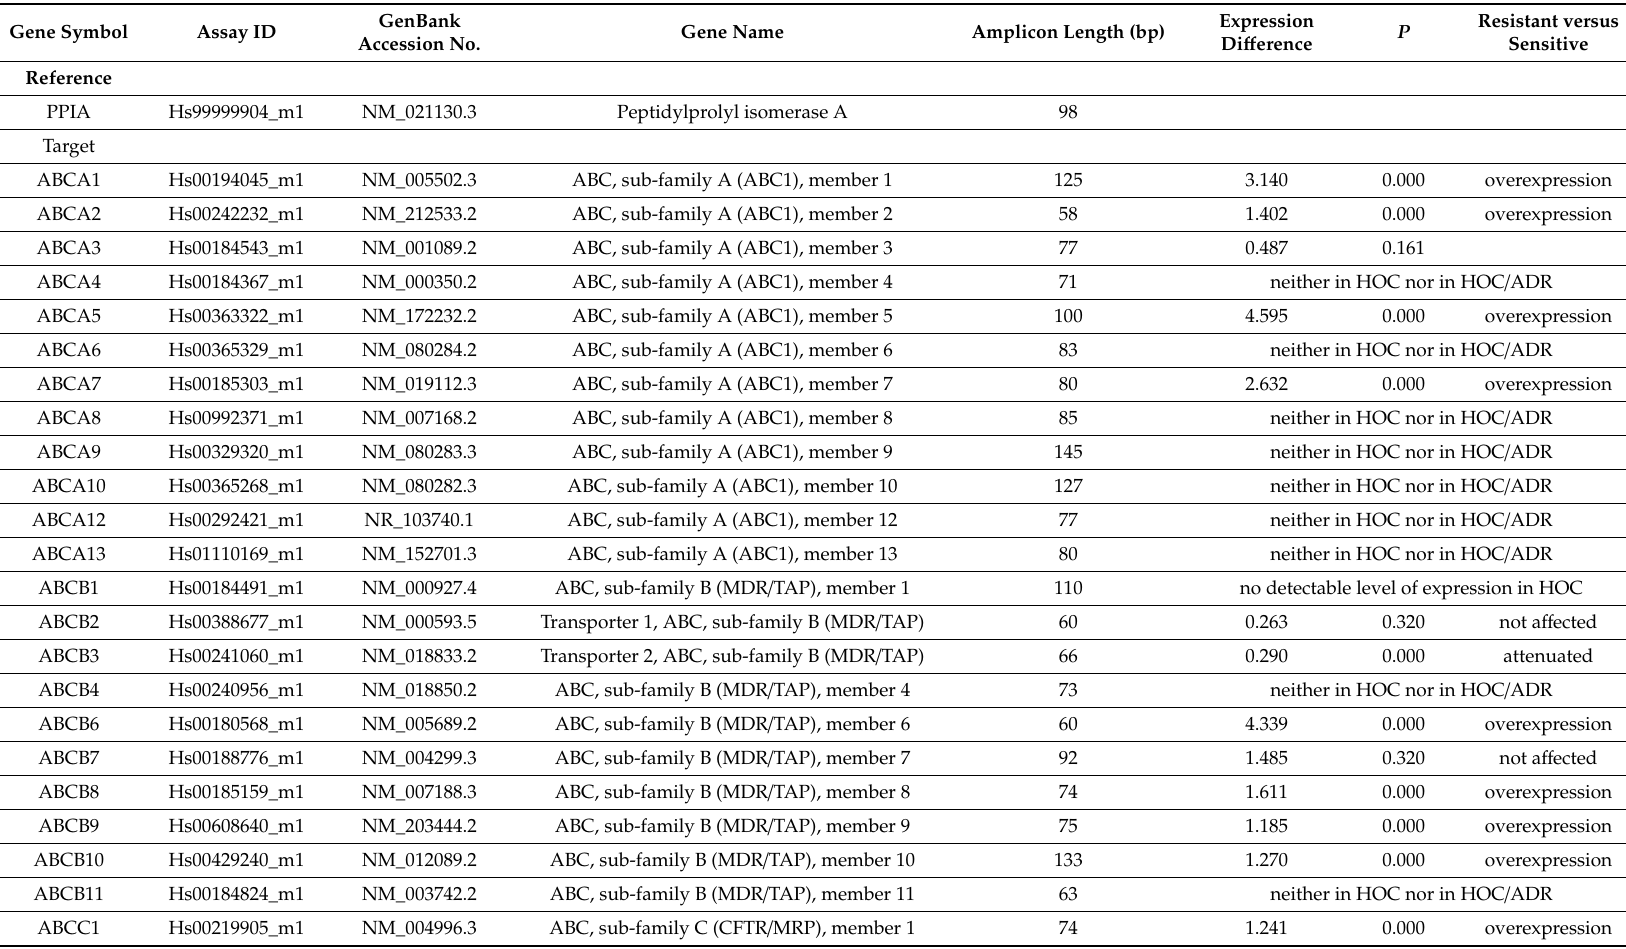
Table A1. Comparison of ABC (ATP-binding cassette) superfamily genes expression profiles in doxorubicin-sensitive HOC and -resistant HOC / ADR cell